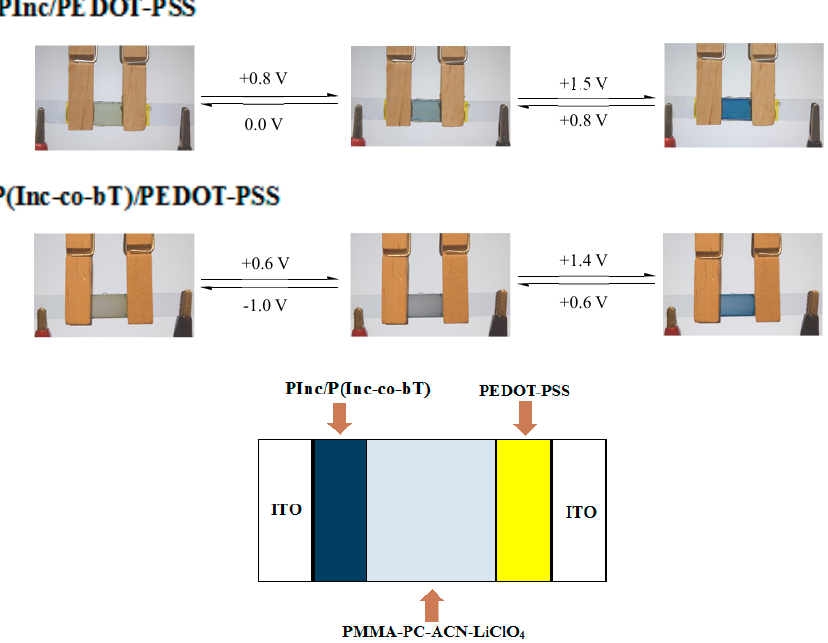
Figure 1. Schematic diagrams of PInc/PMMA-PC-ACN-LiClO 4 /PEDOT-PSS and P(Inc- co -bT)/PMMA- PC-ACN-LiClO 4 /PEDOT-PSS devices.